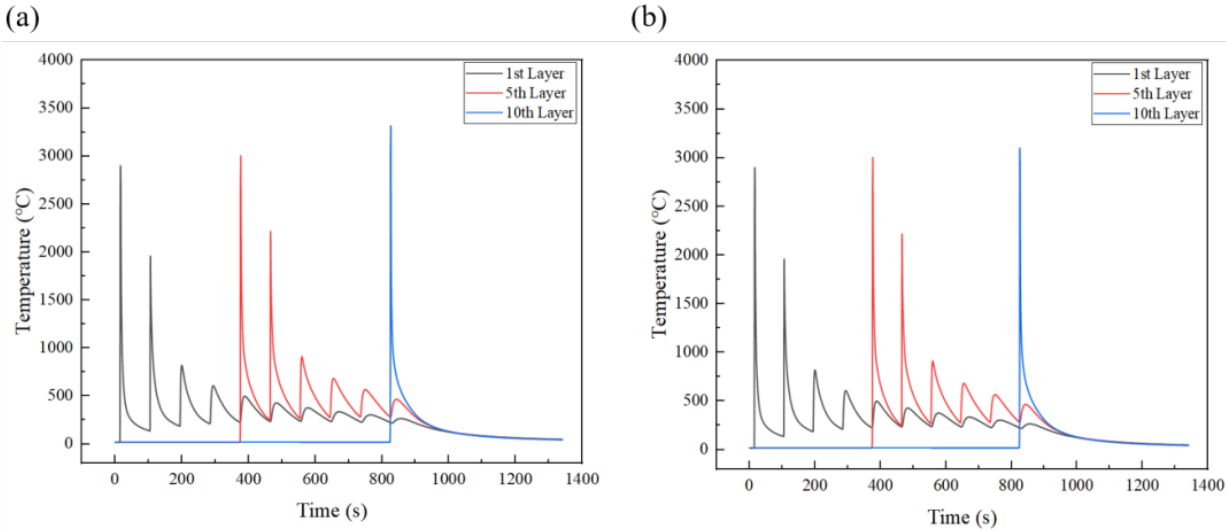
Figure 10. Thermal cycling curves at different midpoints for different paths. ( a ) SMD scan path. ( b ) RM scan path.